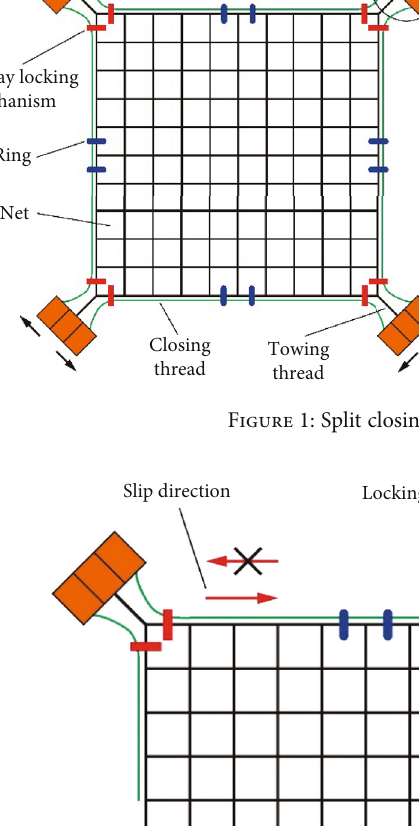
Figure 2: Sliding direction of one-way locking mechanism.